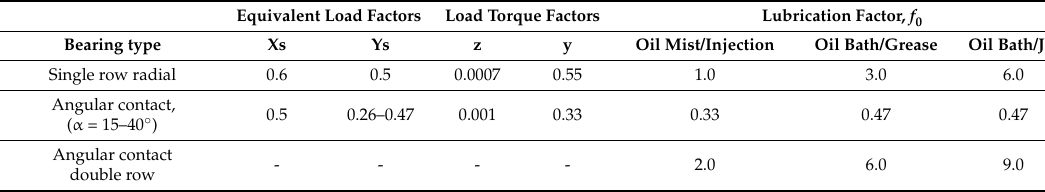
Table 4. Values of load factor, torque factor, and lubrication factor